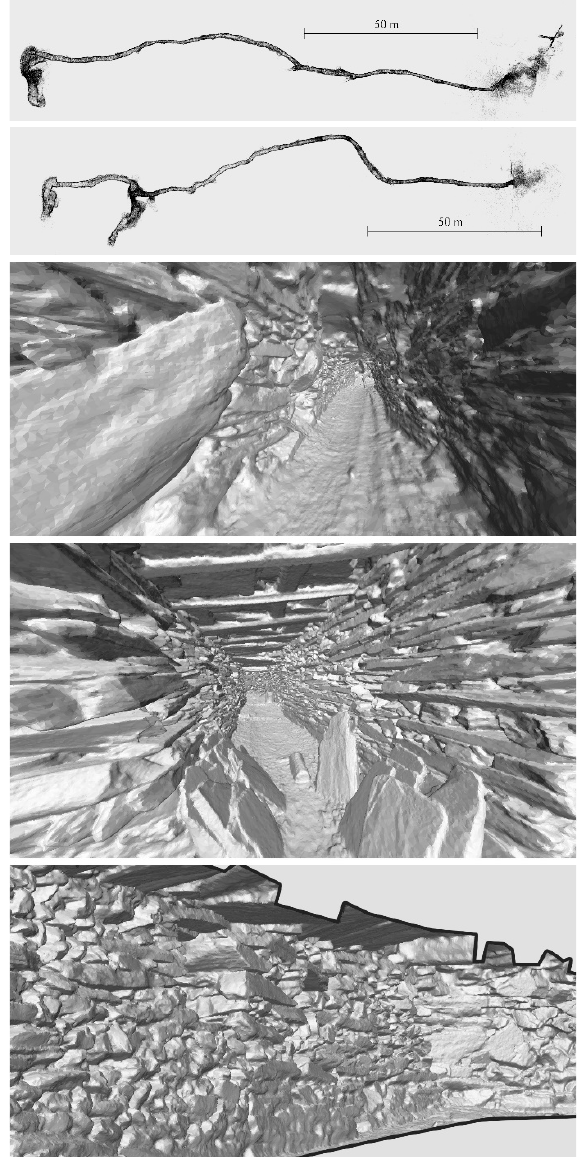
Table 1. Summary of the main information regarding the tunnels acquired with the Ant3D multi-camera system.